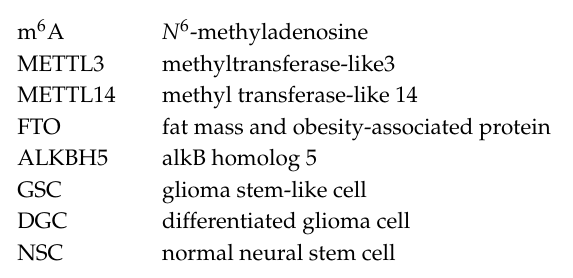
Figure S1: m 6 A peak distribution, Figure S2: GSC specific histone activated genes relate to METTL3 direct targets, Figure S3: GSC specific histone activated genes relate to METTL3 indirect targets, Figure S4: Distribution of METTL3 dependent RNA editing events, Figure S5: METTL3 and m 6 A modification in RNA processing, Figure S6: METTL3 regulate the exon skipping of MDM2, Figure S7: Regulation of lincRNAs and miRNAs by METTL3 in GSCs, Figure S8: Pathways regulated by direct and indirect METTL3 targets, Figure S9: Regulation of NOTCH pathway by METTL3 mediated m 6 A modification, Table S1: m 6 A peaks identified in shNT GSC, Table S2: m 6 A peaks identified in shMETTL3 GSC, Table S3: Differentially expressed Genes in shMETTL3 GSC - shNT GSC, Table S4: GSC specific gene sets used for analysis, Table S5: Differential splicing events between shNT and shMETTL3 GSC, Table S6: Coordination of m 6 A with RBPs, Table S7: miRNAs binding to m 6 A modified 3’UTR genes, Table S8: DAVID pathway analysis for direct and indirect targets of